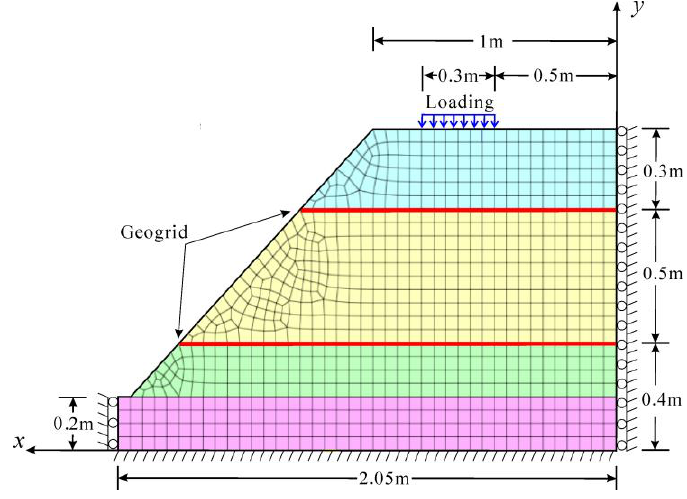
Figure 3. Finite element model.